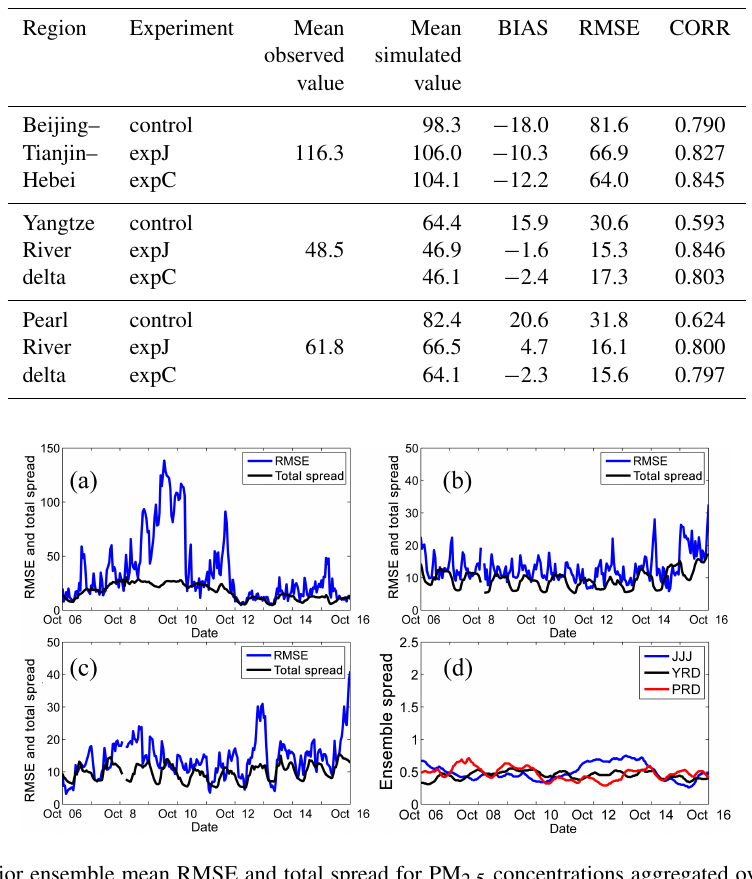
Figure 3. Time series of prior ensemble mean RMSE and total spread for PM 2 . 5 concentrations aggregated over all observations over the three sub-regions: (a) Beijing–Tianjin–Hebei region, (b) Yangtze River delta and (c) Pearl River delta. (d) Time series of the area mean ensemble spread for λ PM over the three 2 . 5